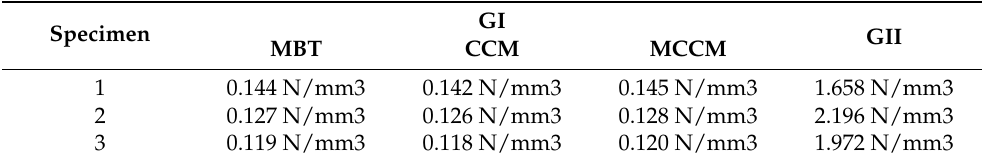
Table 1. G I and G II for steel/CFRP part.